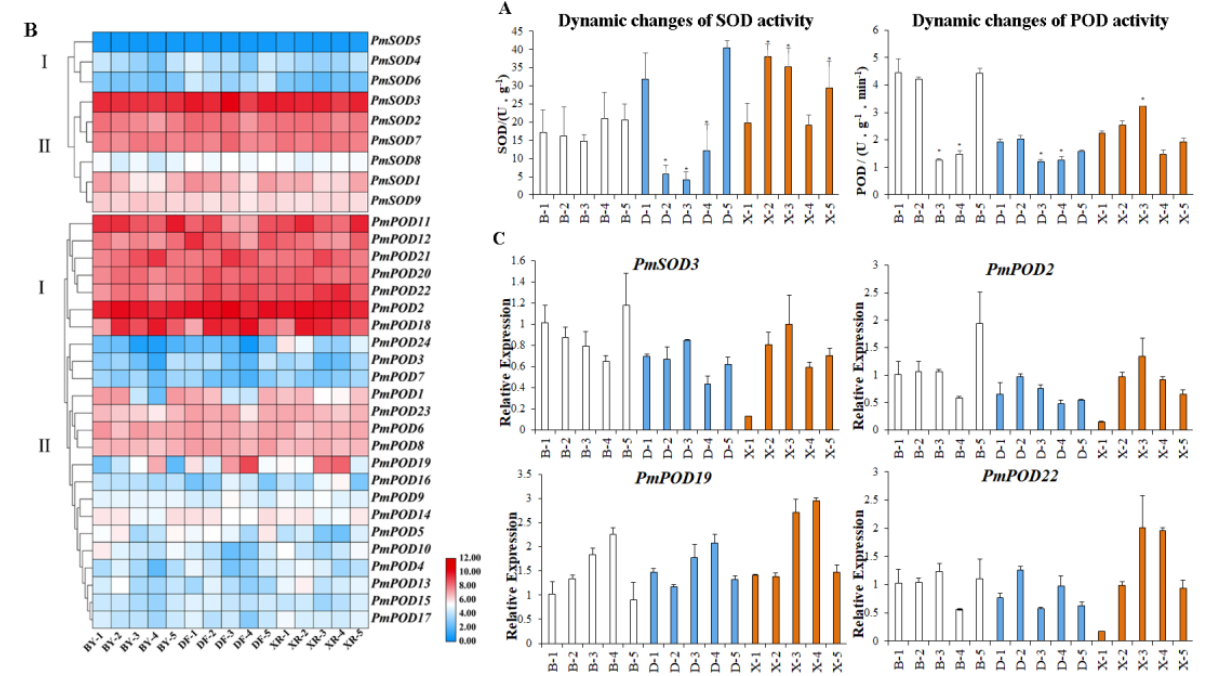
Figure 6. SOD and POD enzyme activity changes and encoding gene expression patterns of three P. mume varieties under cold stress: ( A ) measurement of SOD and POD enzyme activities ( p < 0.05, marked by *); Heatmap ( B ); and relative expressions ( C ) of genes encoding SOD and POD enzymes in P. mume in response to cold. B, D, and X in axis X refer, respectively, to BY, DF, and XR, and 1 – 5 refer to different stages of cold treatment: 1 is control, at which the ambient temperature was 25 °C ; 2 is 4 °C treatment for 8 h; 3 is 4 °C treatment for 5 d; 4 is temperature drop to − 5 °C ; and 5 is temperature increase to 15 °C after cold treatment. A rate of 1 °C per hour was maintained throughout the rise and fall stabilization process.